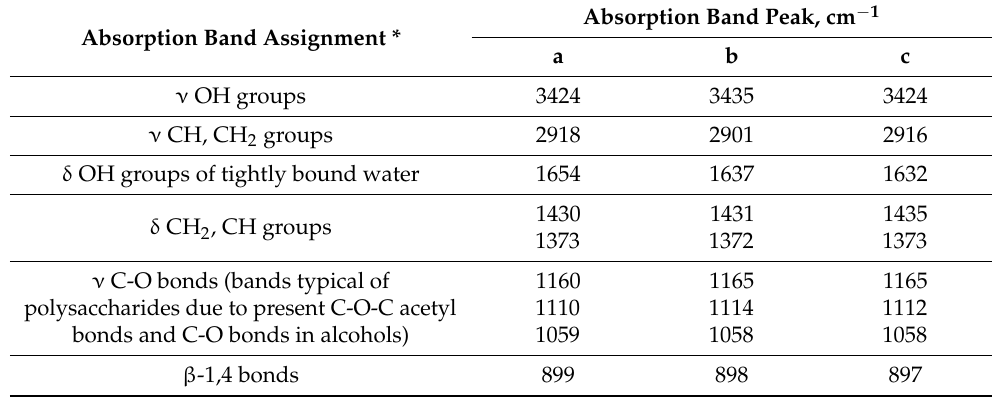
Table 2. Absorption band assignment for functional groups of cellulose samples.